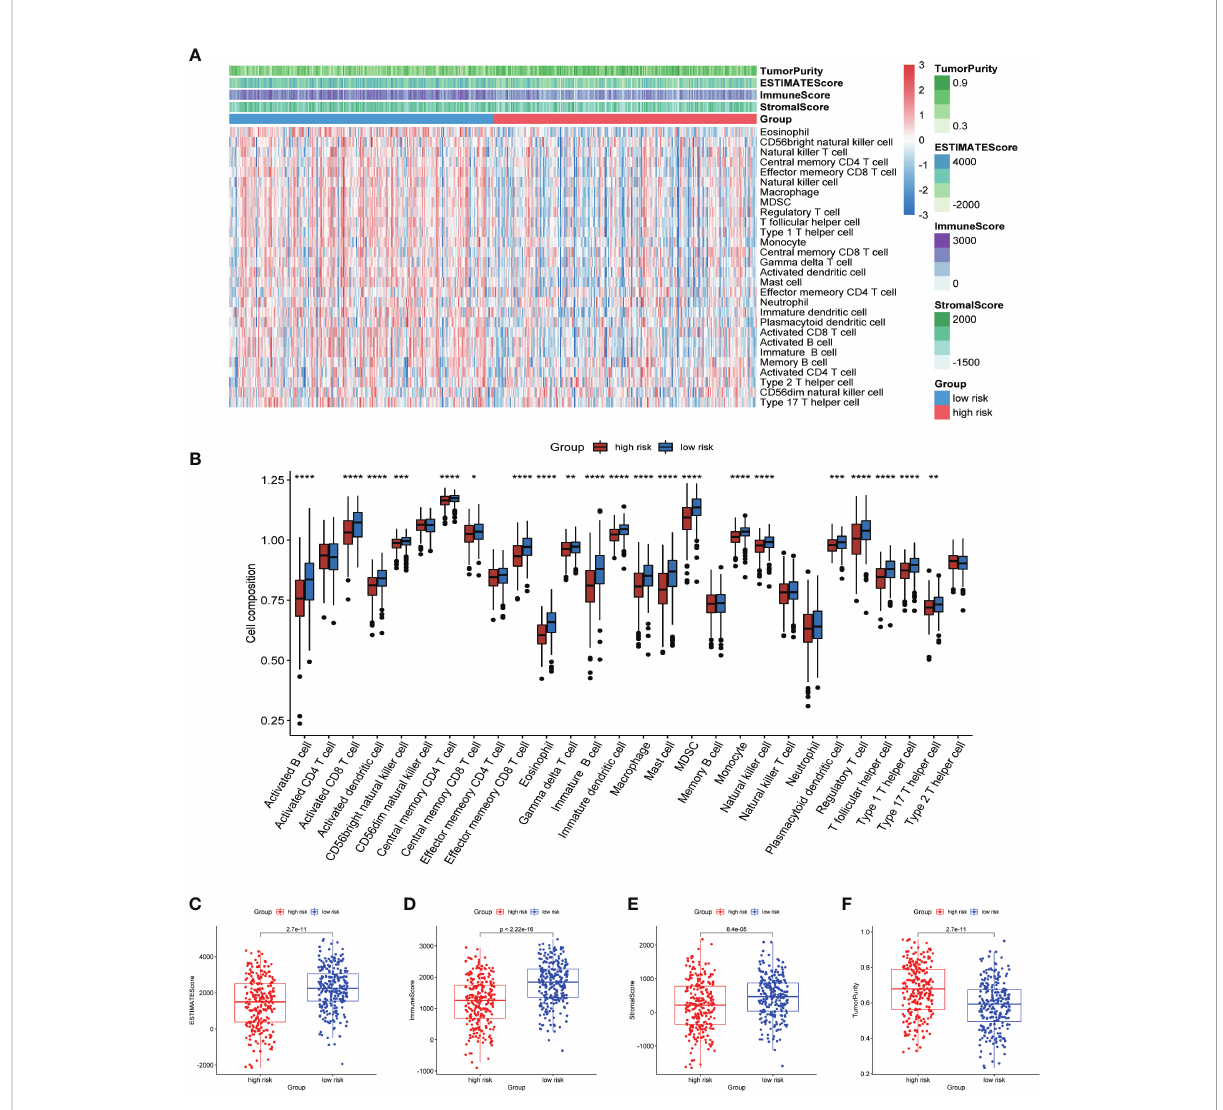
FIGURE 7 Analysis of TME cell in fi ltration. (A) Heatmap showing ssGSEA scores, ESTIMATE score, immune score, stromal score, and tumor purity between high- and low-risk groups. (B) The differences in the proportions of 28 immune cells between high- and low-risk groups. Differences of ESTIMATE score (C) , immune score (D) , stromal score (E) and tumor purity (F) in high- and low-risk groups. P values were shown as: *p < 0.05; **p < 0.01; ***p < 0.001; ****p <